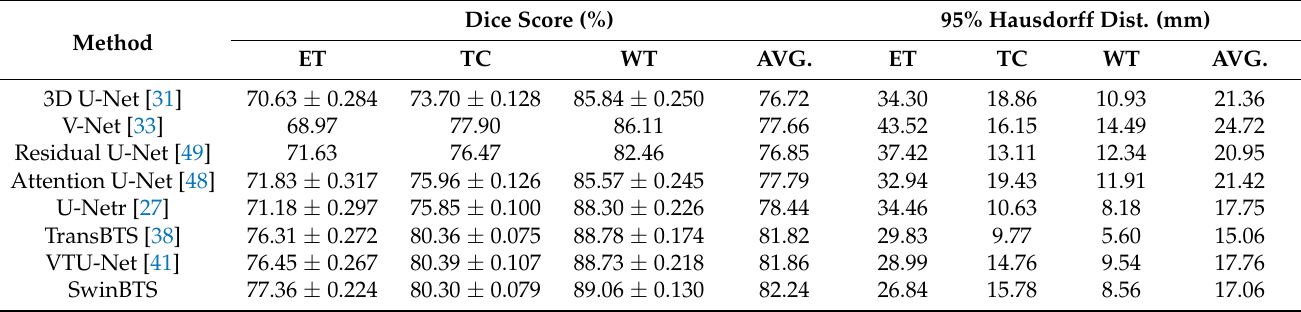
Table 3. Segmentation results on the BraTS 2020 validation dataset.